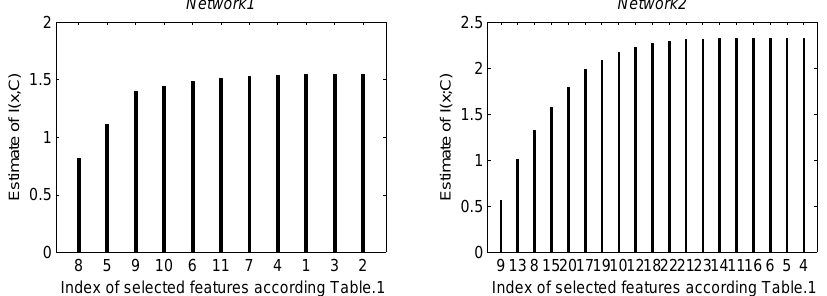
Figure 7. In this figure, the features were selected by the mutual information. The abscissa was the index of selected features at each cycle. There was one-to-one correspondence between the index and the Table 1. For example, the 5th feature was selected at the second cycle in network 1. It indicated that the 5th feature ( γ 2 ) had the greatest mutual information in all of the features except the 8th feature ( N obj 1 ). Its ordinate was the sum mutual information of N obj 1 and γ 2 . In network 1, 11 features were used, and the H ( C ) = 1.5488. In addition, in network 2, 19 features were used, and H ( C ) =